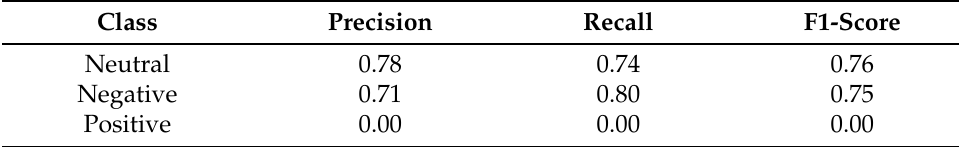
Table A7. Support Vector Machine evaluation.